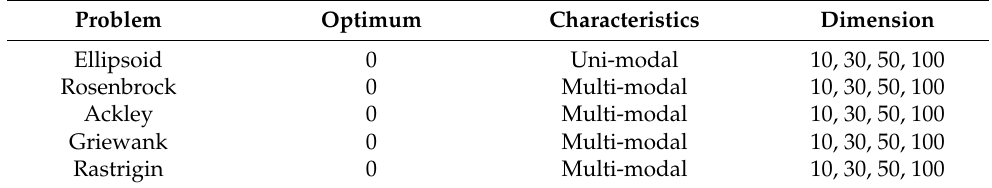
Table 1. Benchmark